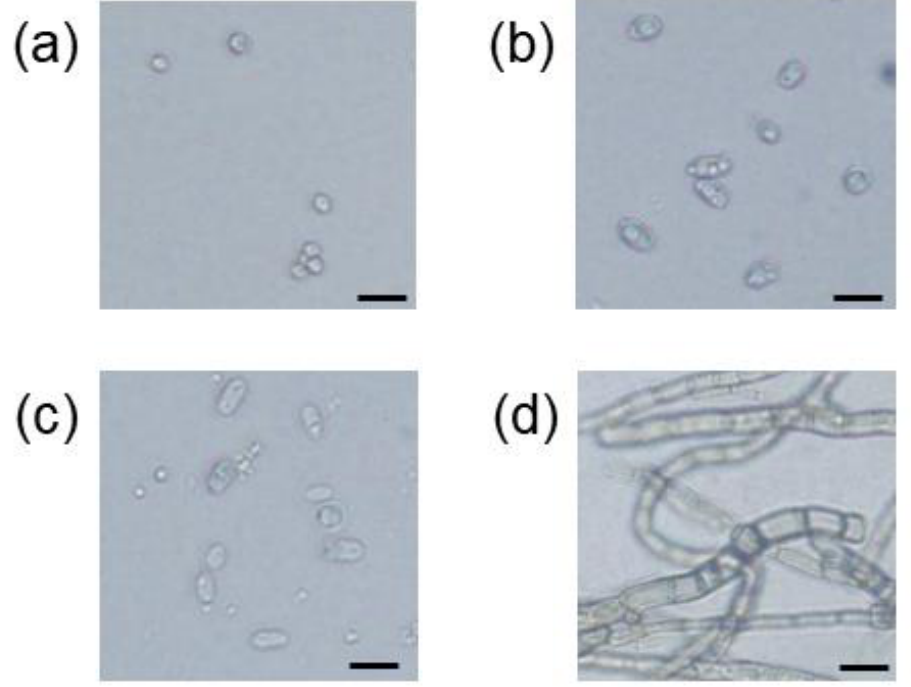
Figure 2. Optical micrographs of cells of the strain I1 ( a ), strain KW1 ( b ), strain TW1 ( c ), and strain TG1 ( d ). Black scale bar = 20 µm.